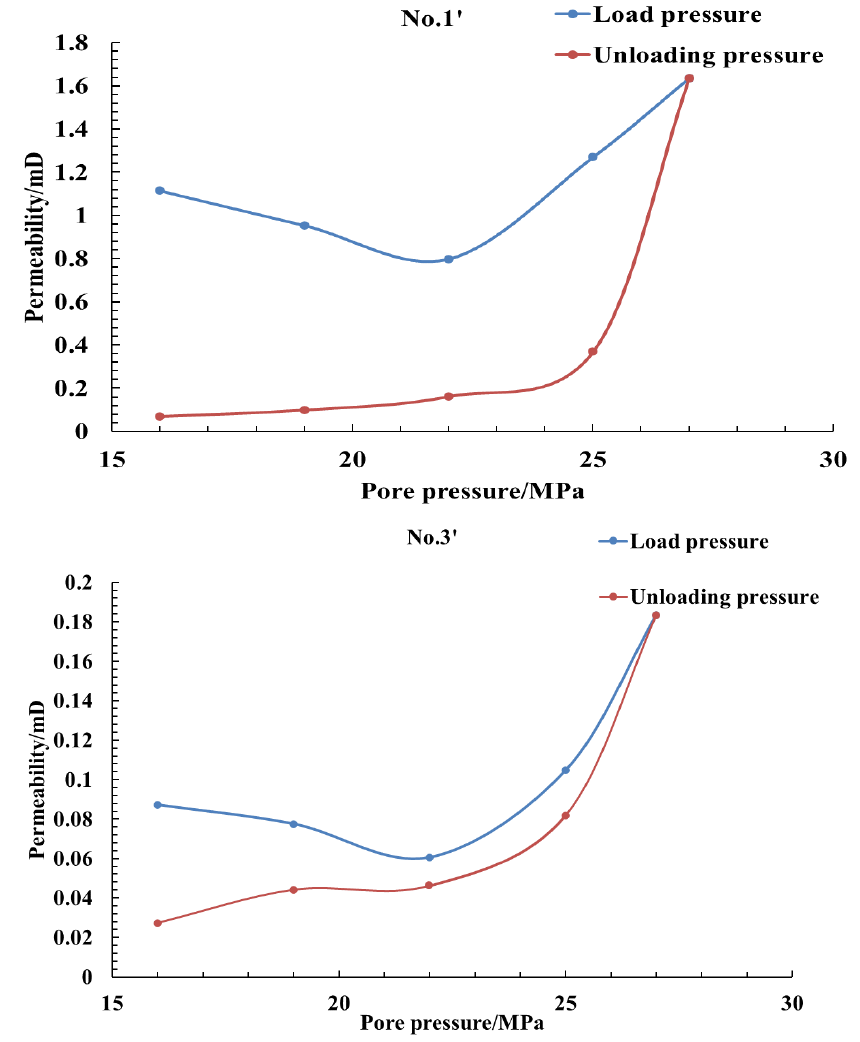
Figure 10. Variation curve of permeability with pore pressure of fractured rock samples.